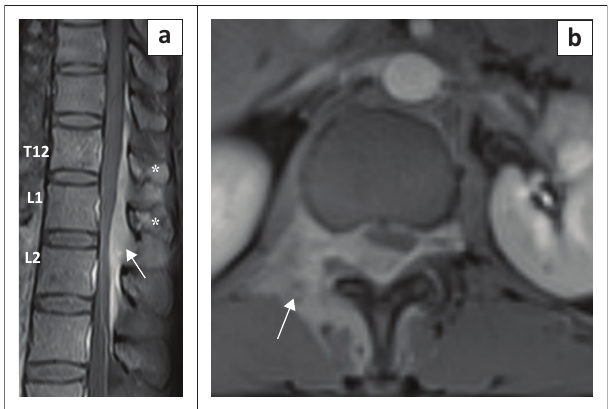
FIGURE 4: Sagittal (a) and axial (b) post contrast images demonstrate mild enhancement of the involved vertebral body (T12) and posterior elements (asterisks, a) with avid homogeneous enhancement of the infiltrative soft tissue (arrows). T12, thoracic vertebra 12.